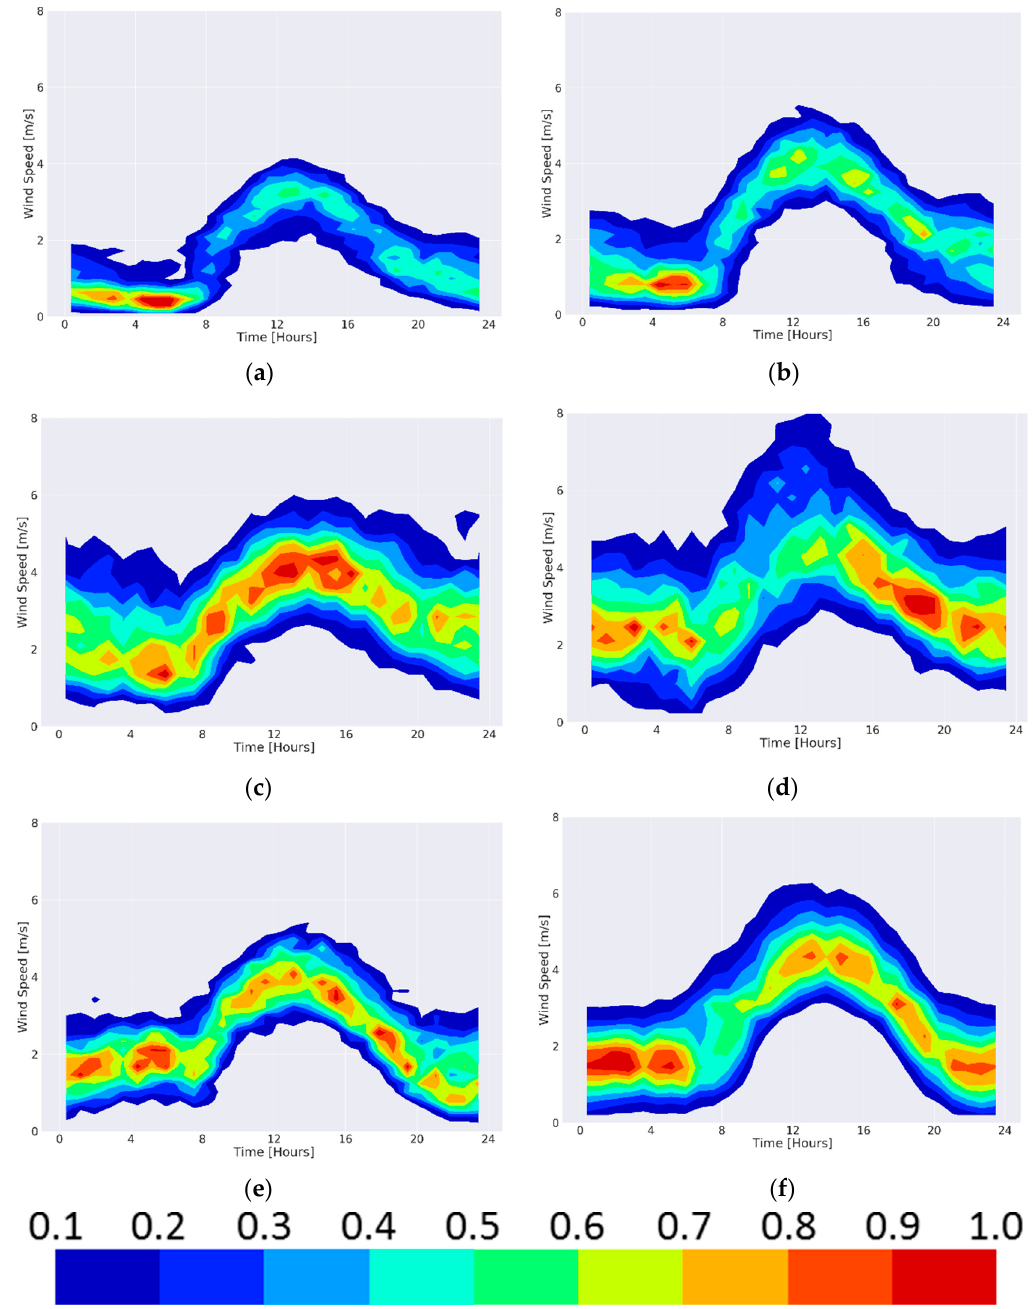
Figure 3. Nonparametric bivariate density of the wind speed of representative weather stations ( a ) Z4–Kiryat Bialik ( b ) Z2–Kiryat Motzkin ( c ) C4–Leah street, Haifa ( d ) C9–Tel Hai elementary school, Haifa, ( e ) TI–The world Zionist. Organization house Tel-Aviv ( f ) TO-Israeli meteorological service Beit Dagan. All time points are in LST (UTC + 2).